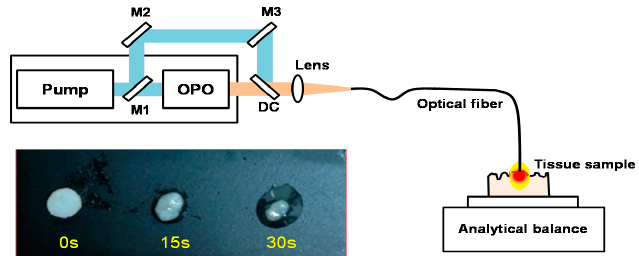
1 W. OPO: OPO cavity, M#: mirror, DC: dichroic